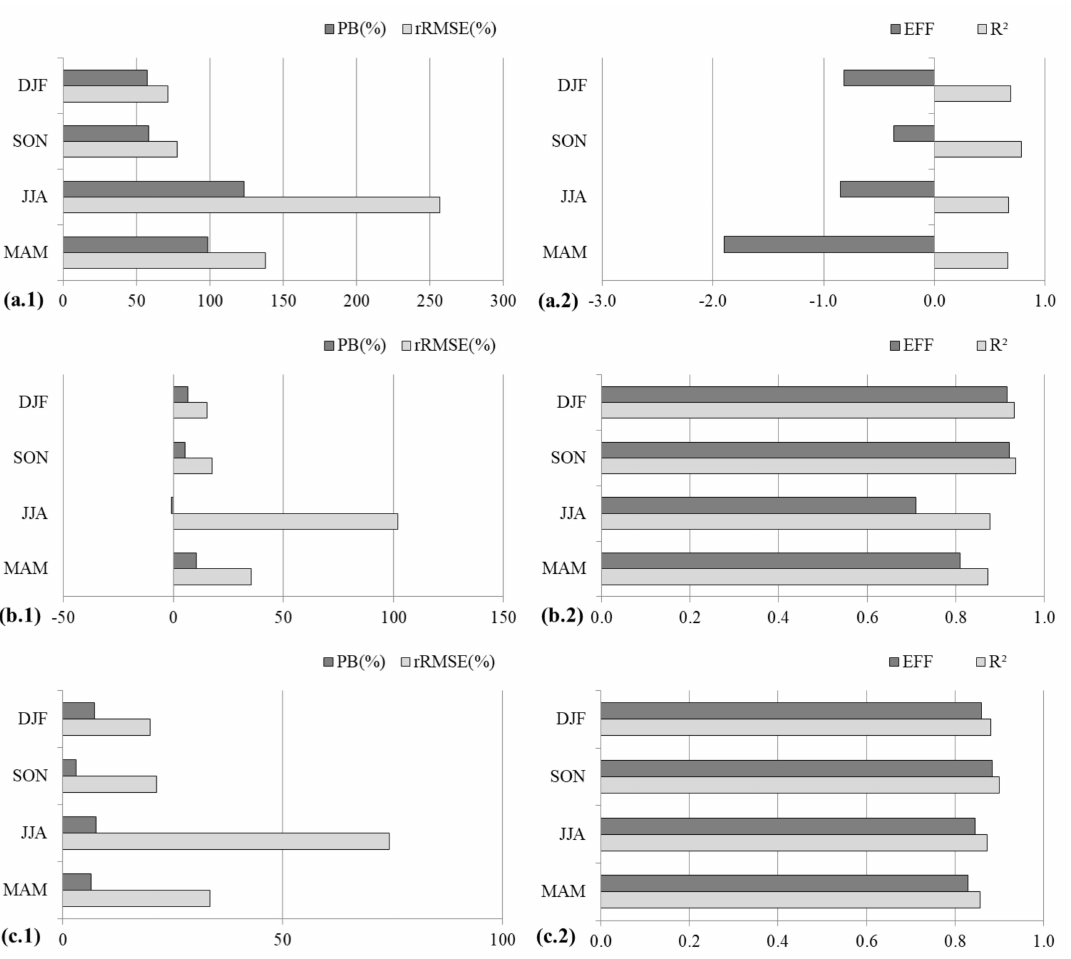
Figure 5. Seasonal variations in (a.1, b.1, c.1) PB and rRMSE, and in (a.2, b.2, c.2) EFF and R 2 , for the periods (DJF, SON, JJA, and MAM), for the precipitation at meteorological stations and precipitation estimated by ( a ) Eta, ( b ) TRMM, and ( c )